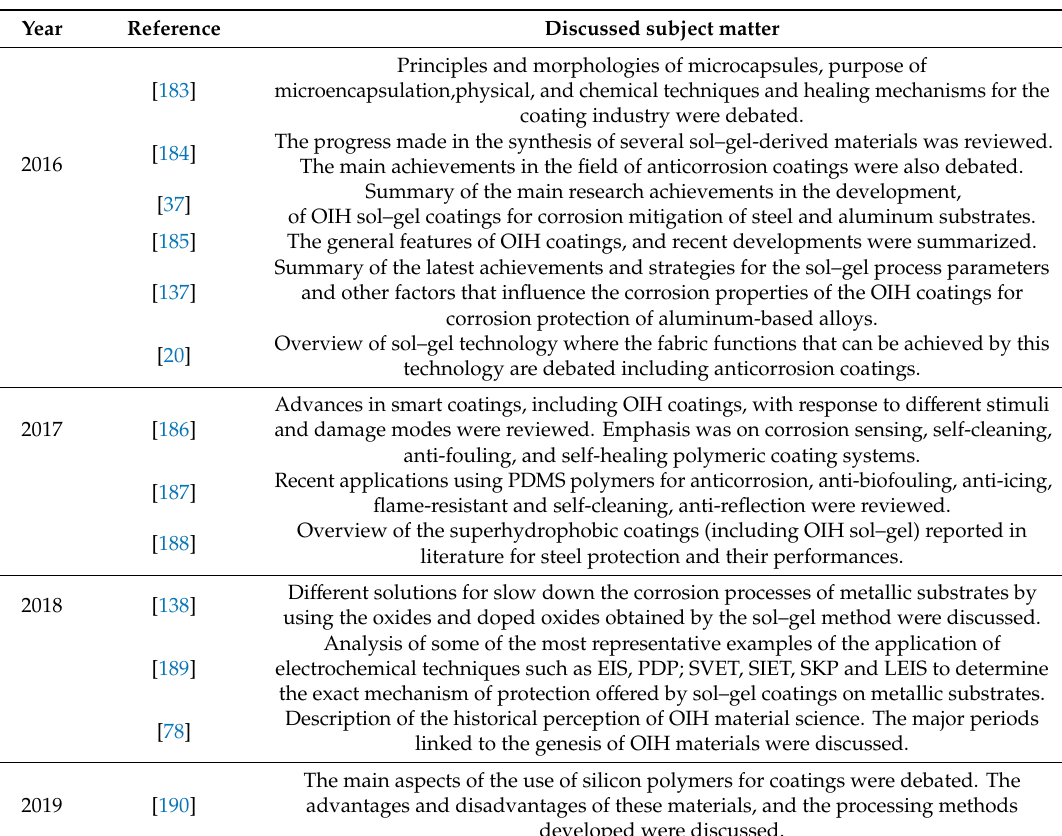
Table 2. The most relevant review manuscripts focused on OIH sol–gel materials published in the last few